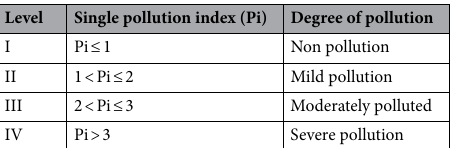
Table 3. Single pollution index grading standards (adapted from Wang et al. 43 ).